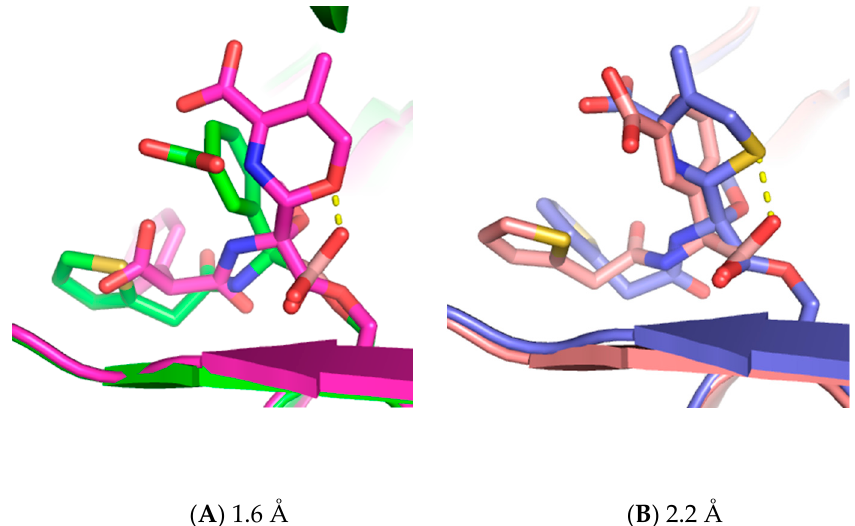
Figure 4. ( A ) Overlay of E. coli AmpC bound to SM23 (CEF analog) (green) or moxalactam (purple). ( B ) Overlay of FOX-4 bound to SM23 (pink) or cefoxitin (blue). O1 is placed in the oxyanion hole. O2 presumptive position of deacylating water molecule in the transition state. The dashed line indicates the distance between the dihydrothiazine ring and O2. The longer distance for FOX-4 suggests that the attacking water is more easily accommodated in this active site, explaining the rapid turnover of cephamycins.